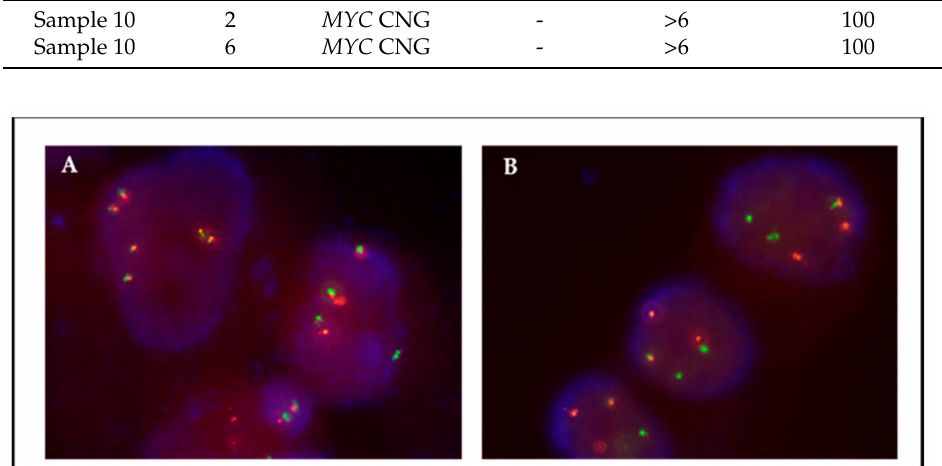
Figure 2. Patient 12, FISH ROS1 on passage 1; ( A ) 76% of the adherent cells were translocated; ( B ) 100% of the floating cells showed translocations. Translocation is observed as isolated green and orange